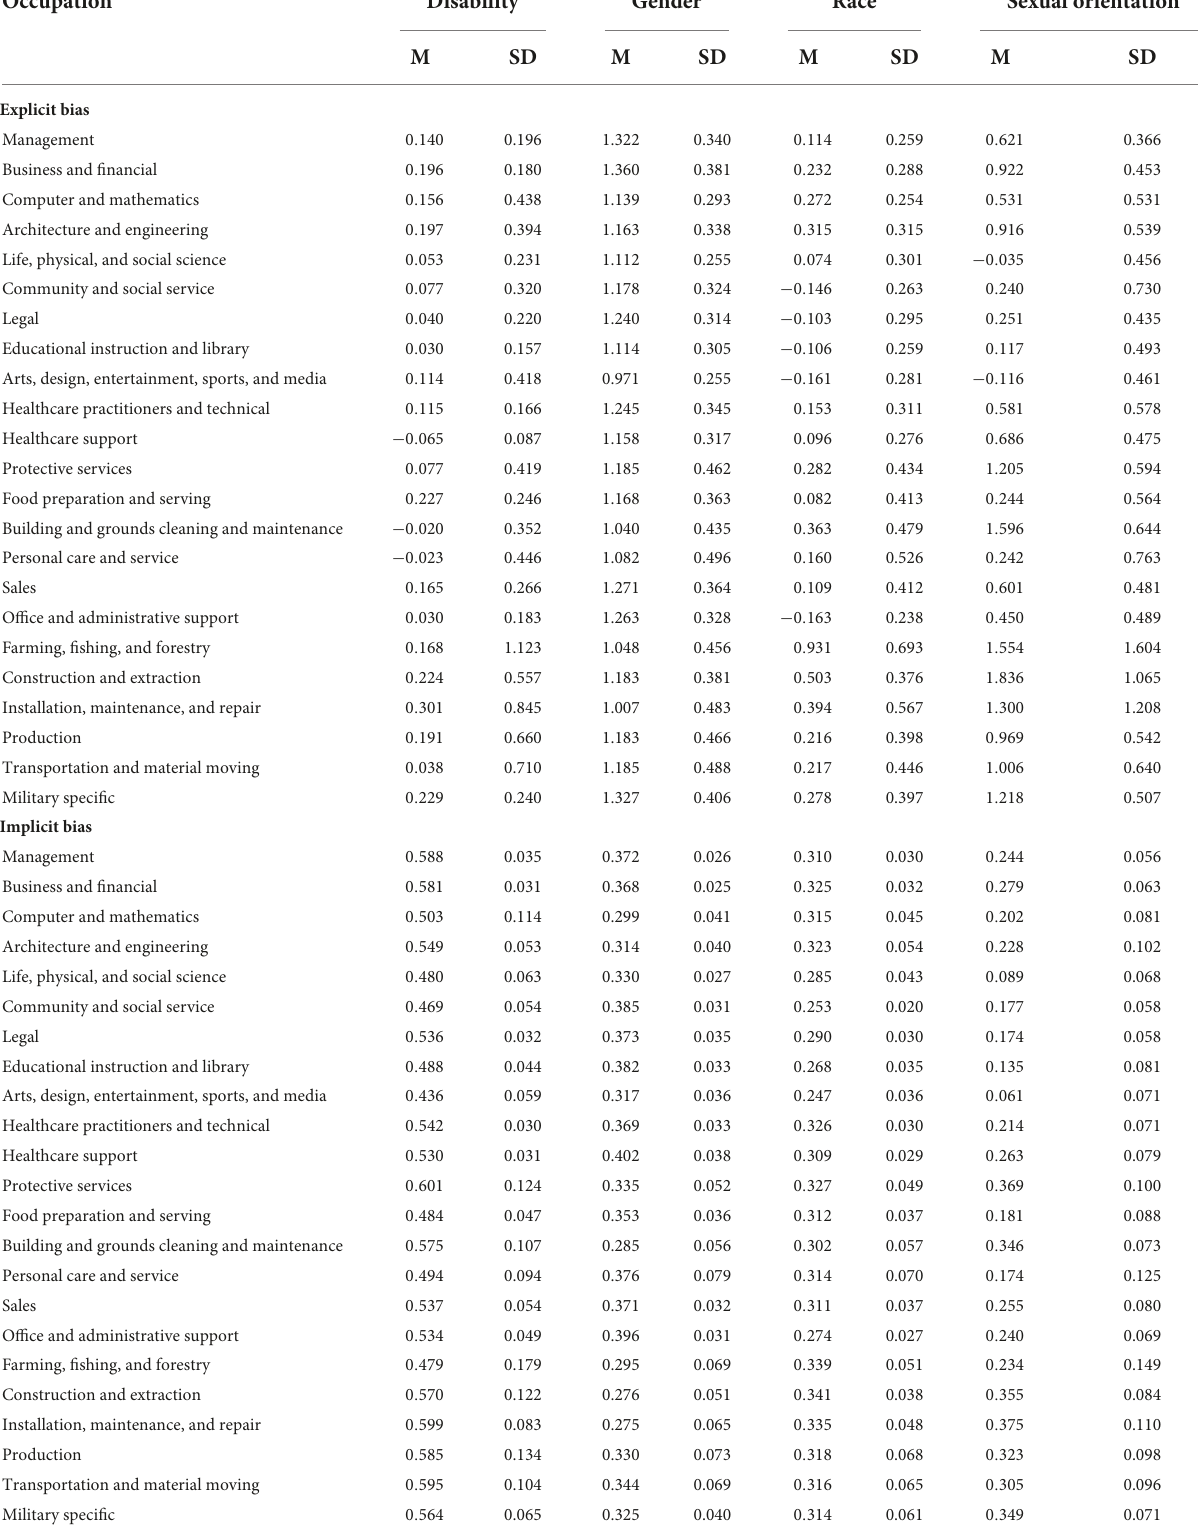
TABLE 2 Means and standard deviations of explicit bias and implicit bias, across